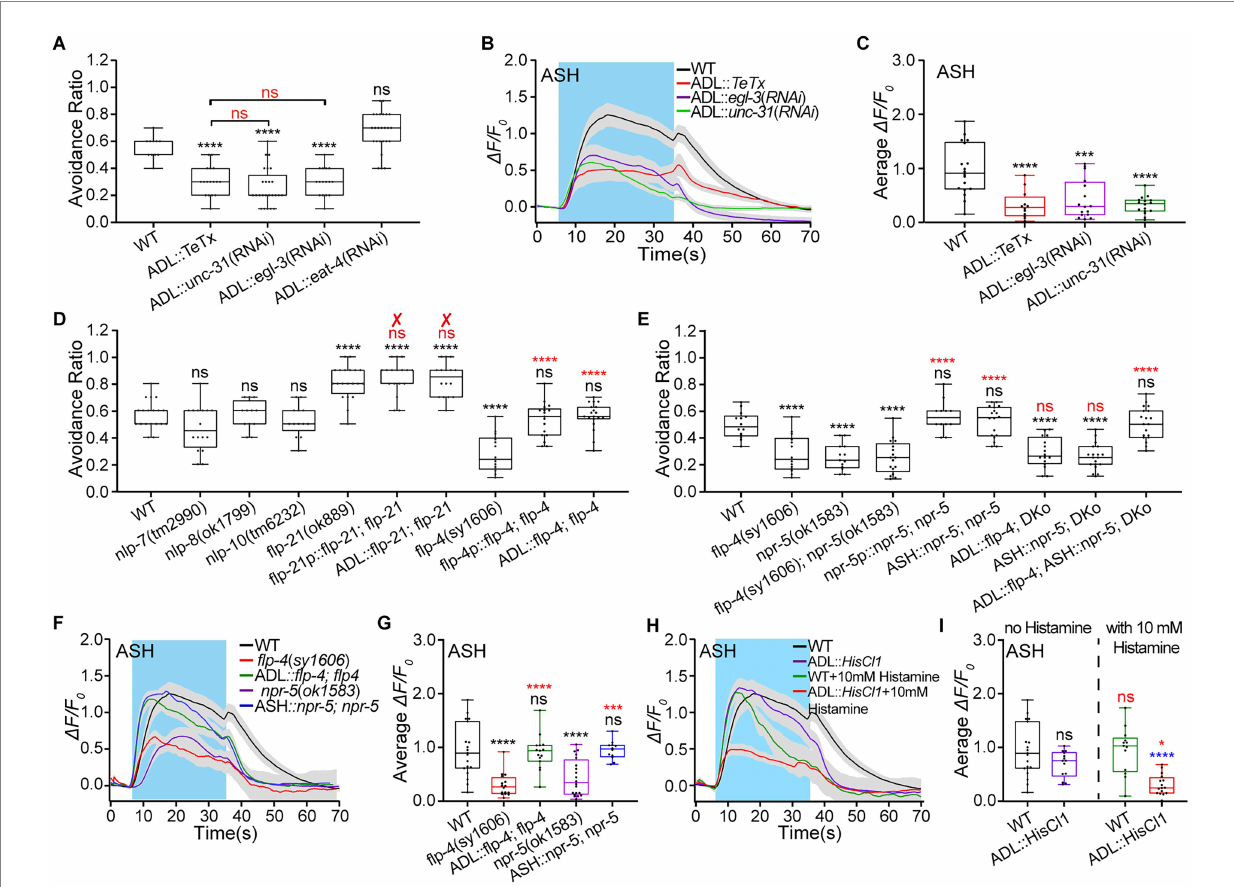
FIGURE 2 ADL excites ASH via the FLP-4/NPR-5 signaling pathway to promote animal avoidance of 0.88 Osm hyperosmolality. (A) . Ratio of avoidance of a droplet of the 0.88 Osm glycerol/M13 hyperosmotic solution in wild-type (WT) N2 (as a control) and transgenic animals of indicated genotypes. (B,C) The somal calcium transients in paired ASH sensory neurons responding to the hyperosmolality in WT N2 and transgenic animals of indicated genotypes. (B) Curves of Ca 2+ transients presented as means (solid traces) ± SEM (gray shading) with cerulean background indicating the application of 0.88 Osm glycerol/M13 solution; (C) Box plots of the average intensity of Ca 2+ signals of the ON response during glycerol/M13 solution perfusion with each dot representing the data from each tested worm. (D,E) Ratio of animals’ avoidance of a droplet of the hyperosmotic solution in animals of indicated genotypes. “ ✘ ” means the failure to restore WT behavior by the genetic rescue indicated. (F,G) The somal calcium transients in paired ASH sensory neurons in response to the application of the hyperosmolality in animals of indicated genotypes. (F,H) Curves of Ca 2+ transients presented as means (solid traces) ± SEM (gray shading) with cerulean background indicating the application of 0.88 Osm glycerol/M13 solution; (G,I) Box plots of the average intensity of Ca 2+ signals of the ON response during glycerol/M13 solution perfusion with each dot representing the data from each tested animal. Heat maps of Ca 2+ signals are shown in Supplementary Figure S2. Statistical significance is indicated as and in different colors: ns, not significant, * p < 0.05, *** p < 0.001, and **** p < 0.0001; black, the tested vs. the WT; red, the gene rescued vs. the related mutant, or the histamine treated vs. the histamine untreated of the same genotype (in I ); blue, the tested vs. WT under histamine treatment (in I